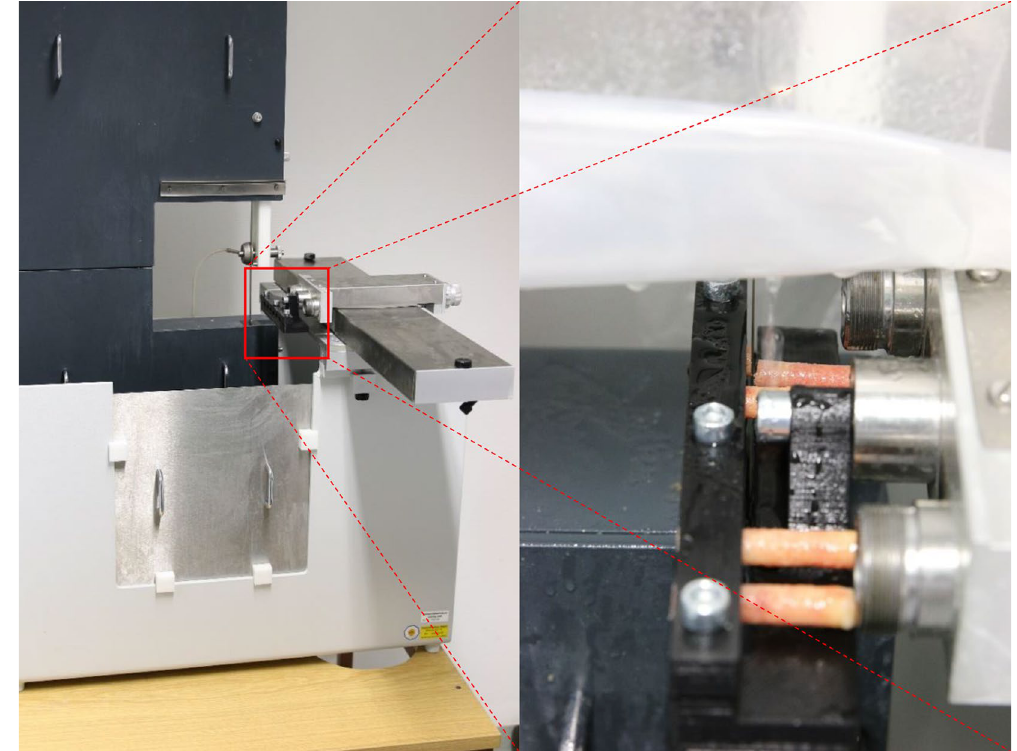
Figure 2. Self constructed and 3D printed clamping jaws are mounted at the parallel guidance of the band saw. The mounted section of the drill core is later used as mechanical specimen. Sawing was carried out under permanent water